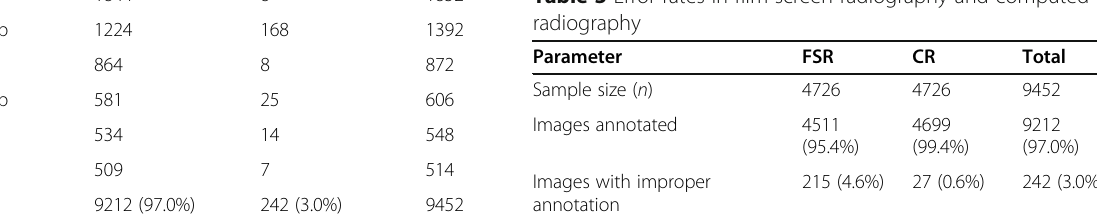
Table 3 Error rates in film-screen radiography and computed